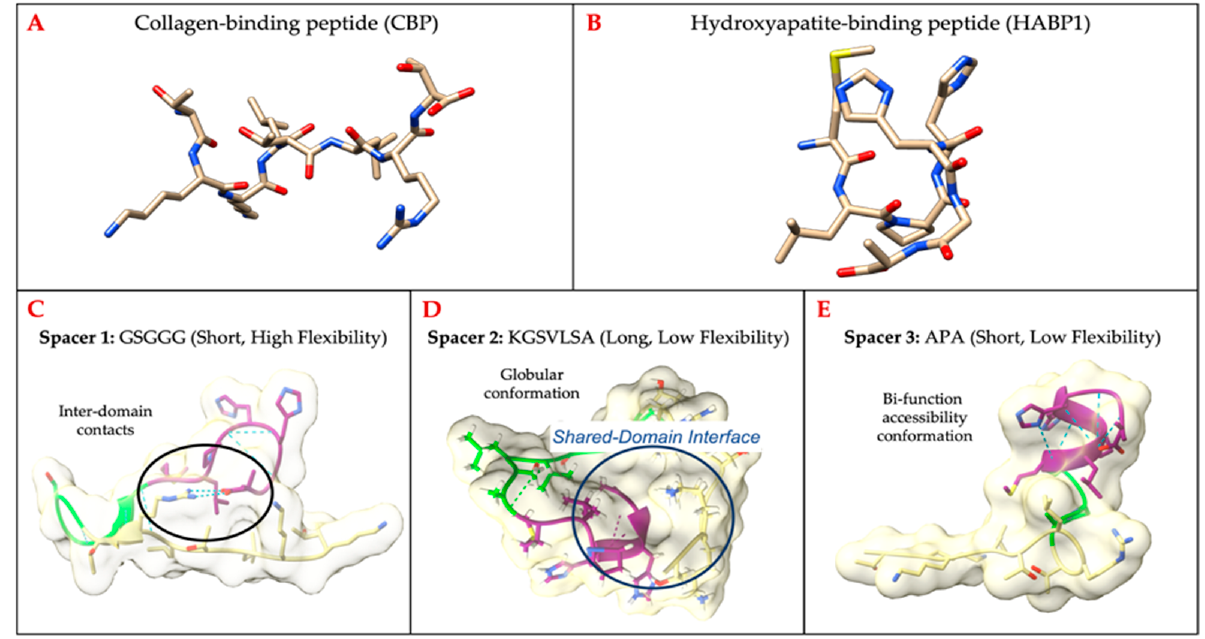
Figure 3. Folded peptide structures generated by PEP-FOLD3: ( A ) CBP and ( B ) HABP1. Building chimeric peptide CBP-HABP1: ( C ) short spacer with high flexibility, ex: GSGGG; ( D ) long spacer with low flexibility, ex: KGSVLSA; ( E ) short spacer with low flexibility, ex: APA.